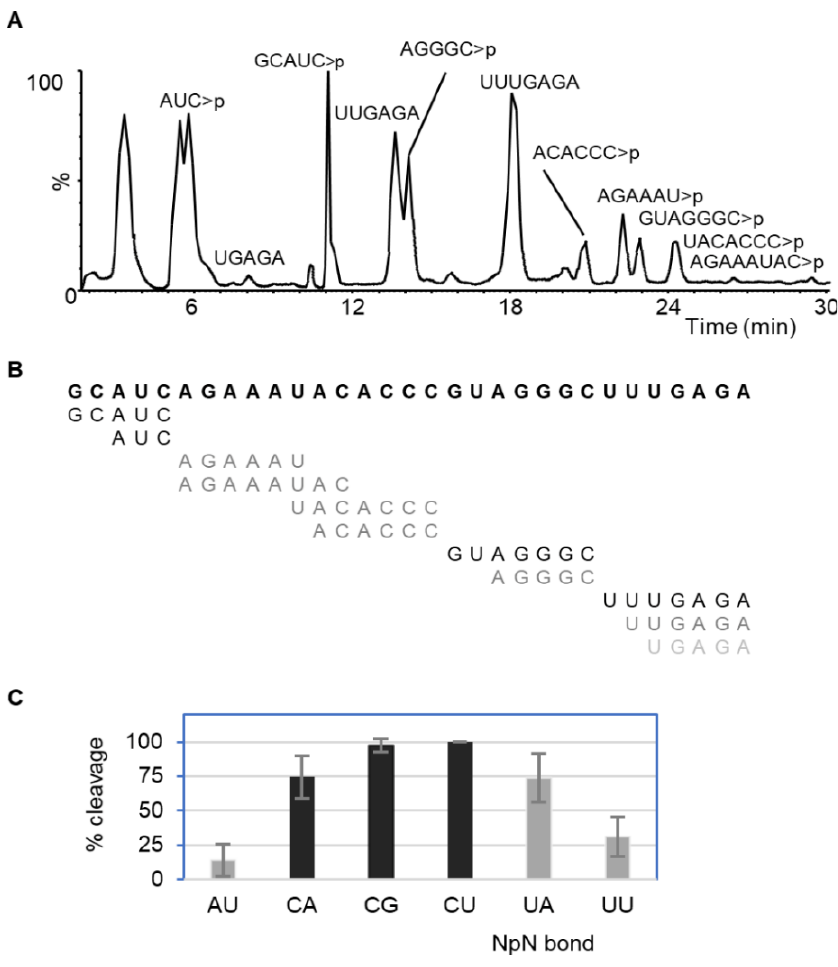
Figure 2. Dinucleotide sequence-dependent RNA cleavage by RNase cusativin. ( A ) TIC annotated with the observed digestion products containing cyclic phosphates (> p ). ( B ) Overlay of the observed digestion products mapped to the original sequence. ( C ) Dinucleotide bonds cleaved by the cusativin. Cleavage efficiency is the percentage of abundance (peak area) ratio of the expected/observed digestion product upon cleavage of specific dinucleotide and that of the undercut oligonucleotide sequences overlapping respective